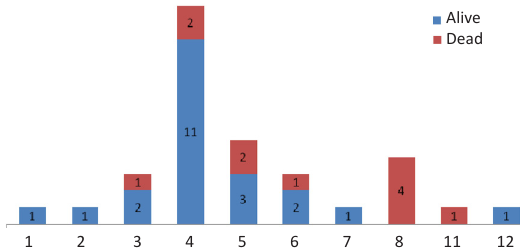
Figure 3. Year-wise monthly encounters